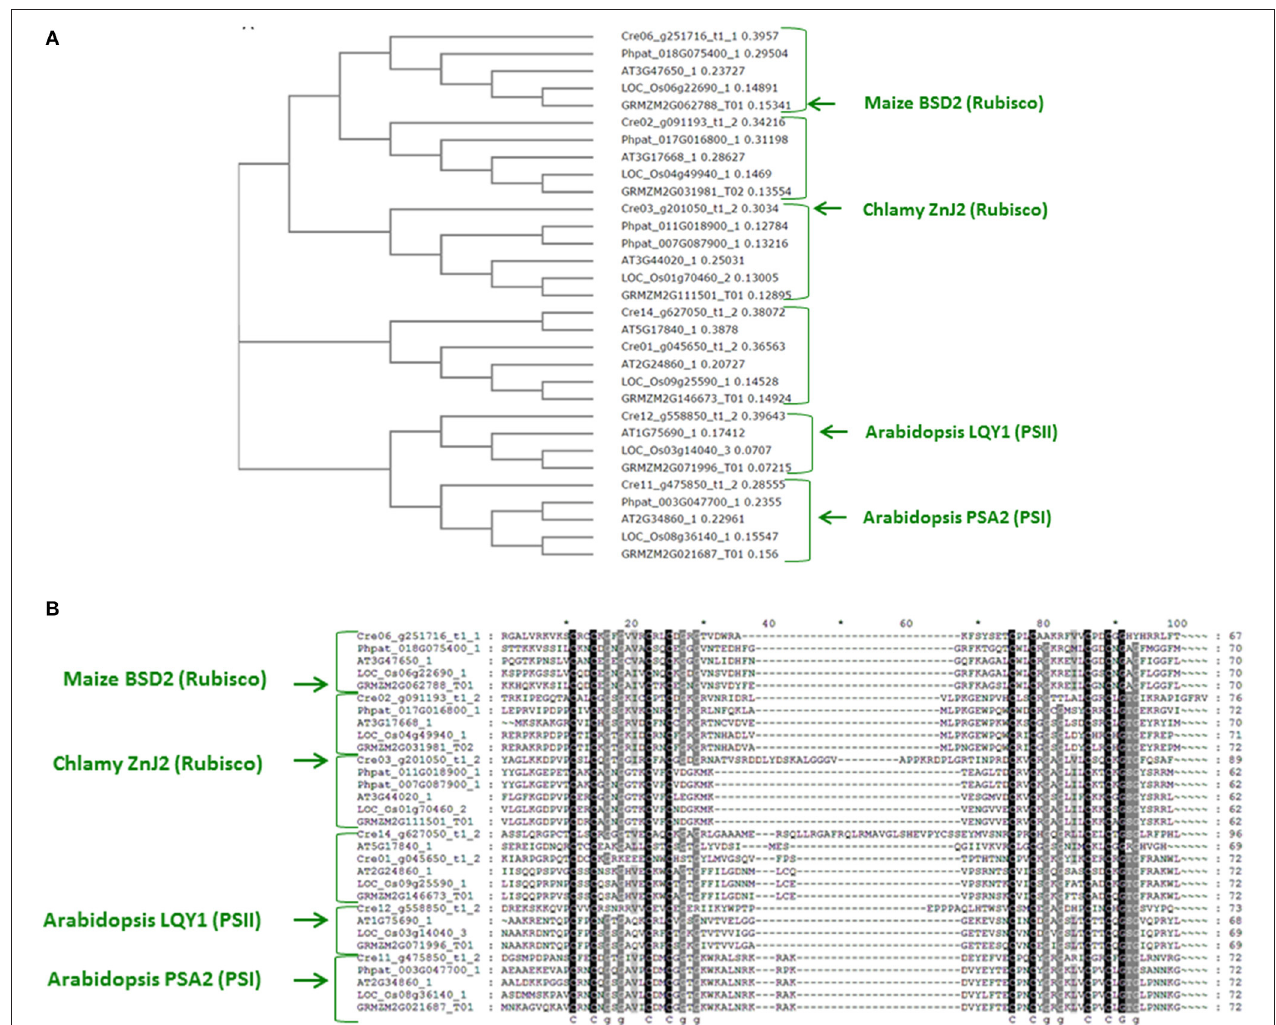
FIGURE 7 | A family of ZnJ2-orthologs is found in photosynthetic organisms (A). ZnJ2-orthologs were retrieved by a BLAST search in the Phytozome V.10 that was restricted to eukaryotic organisms. Searches were based on the amino acid sequence of ZnJ2 from Chlamydomonas reinhardtii (Cre03.g201050.t1.2) and the maize BSD2 (GRMZM2G062788_T01). The retrieved sequences were then aligned by Clustal Omega (former Clustal W2), and the multiple sequence alignment was used to generate a phylogenetic tree, based on the bootstrap test NJ (MUSCLE). The phylogenetic tree was based on genes derived from the genomes of C. reinhardtii (Cre03.g201050.t1.2, Cre12.g558850.t1.2, Cre06.g251716.t1.1, Cre11.g475850.t1.2, Cre01.g045650.t1.2, Cre02.g091193.t1.2, and Cre14.g627050.t1.2), Z. maize (GRMZM5G892742_T03, GRMZM2G111501_T01, GRMZM2G071996_T01, GRMZM2G062788_T01, GRMZM2G146673_T01, GRMZM2G031981_T02, and GRMZM2G021687_T01), A. thaliana (AT2G38000.1, AT3G44020.1, AT1G75690.1, AT3G47650.1, AT2G24860.1, AT3G17668.1, AT5G17840.1, and AT2G34860.1), O. sativa (LOC_Os01g70460.2, LOC_Os03g14040.3, LOC_Os06g22690.1, LOC_Os09g25590.1, LOC_Os08g36140.1, and LOC_Os04g49940.1) and P. patens (Phpat.016G067300.1, Phpat.011G018900.1, Phpat.018G075400.1, Phpat.003G047700.1, and Phpat.017G016800.1). (B). The amino acid sequences of the regions that span the four cystein-rich centers (consisting of the partially conserved CXXCXGXG element) of the ZnJ2 orthologs were aligned by Clustal Omega. The alignment was further processed by GeneDoc version 2.7, to demonstrate sequence conservation. Conserved residues appear with a dark background that ranged from gray to black, based on the degree of similarity.